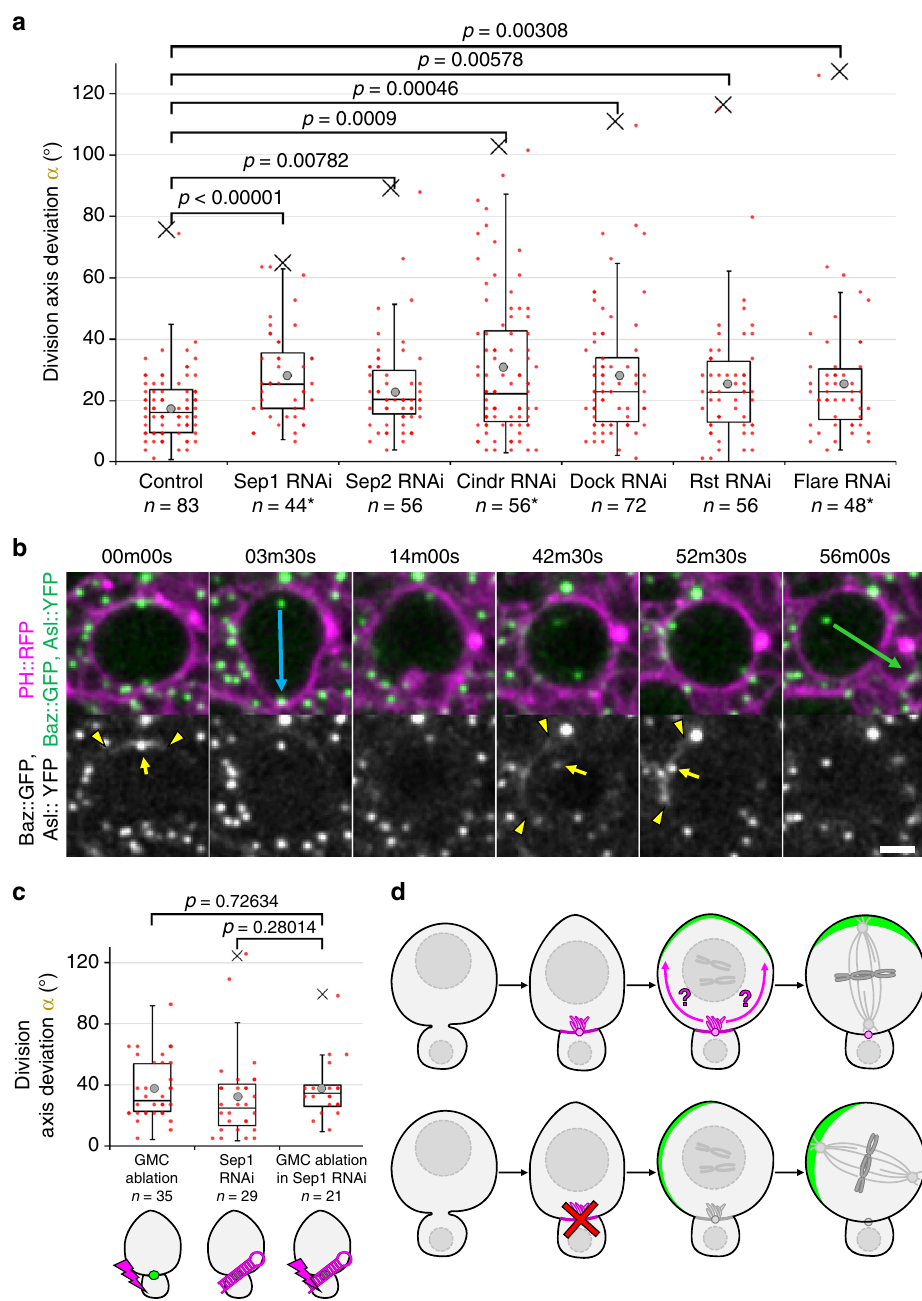
Fig. 5 Components of the NB/GMC interface contribute to NB division axis maintenance. a Deviation of the division axis from one cell cycle to the next in NBs expressing worniu -Gal4-driven RNAi against the indicated components of the NB/GMC interface, as well as the Cindr interactors Rst and Dock. Asterisks: candidates for which protein depletion was con fi rmed. See Methods for precise genotypes. Data from, respectively, 2, 2, 1, 2, 2, 1 and 3 independent experiments. b Two successive division of a NB expressing worniu -Gal4-driven Cindr RNAi. The second division axis (green arrow) deviates from the fi rst one (blue arrow) by 53° (quanti fi ed in a ), due to the mispositioning of the apical Baz crescent (delimited by arrowheads), whereas the apical centrosome (arrow) aligns properly with this crescent. Proper spindle alignment was always observed ( n = 5/5, 4/4, 17/17, 12/12, 4/4 and 6/6 cases with deviation >45°, respectively, in Sep1, Sep2, Cindr, dock, Rst and Flare RNAi). Scale bar: 5 µ m. c Deviation of the division axis following GMC ablation in control NBs (36 ± 20°, n = 35, also shown in Figs. 2c and 3c, data from ten independent experiment), in NBs expressing worniu -Gal4-driven Sep1 RNAi (32 ± 27°, n = 29) and following GMC ablation in NBs expressing worniu -Gal4-driven Sep1 RNAi (37 ± 19°, n = 21). Data from three independent experiments. d Graphical summary of the fi ndings. Top row: the NB/last-born GMC interface, distinguishable from other interfaces by the presence of the midbody and actin-rich plasma membrane extensions (magenta), biases through an unknown mechanism (magenta arrows) the apical polarization (green crescent) of NBs as they round up in mitosis. The mitotic spindle aligns with this crescent, resulting in division axis maintenance. Bottom row: disruption of this mechanism leads to misplaced apical polarization (with which the mitotic spindle still properly aligns) resulting in defective division axis